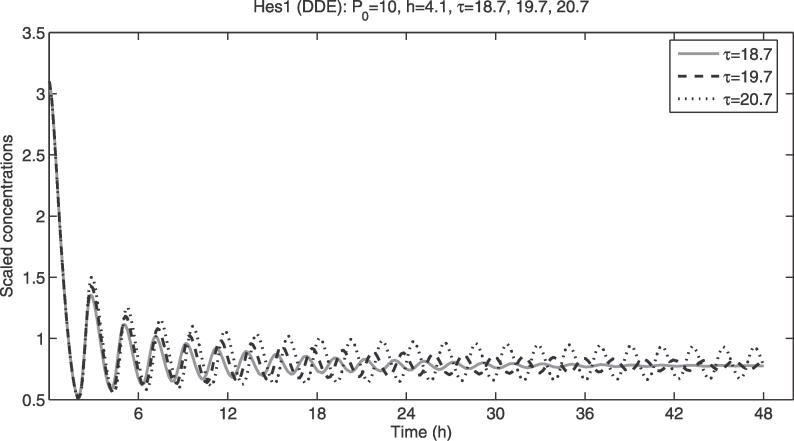
DDE Solution: Exploring the Effect of Delay on Protein